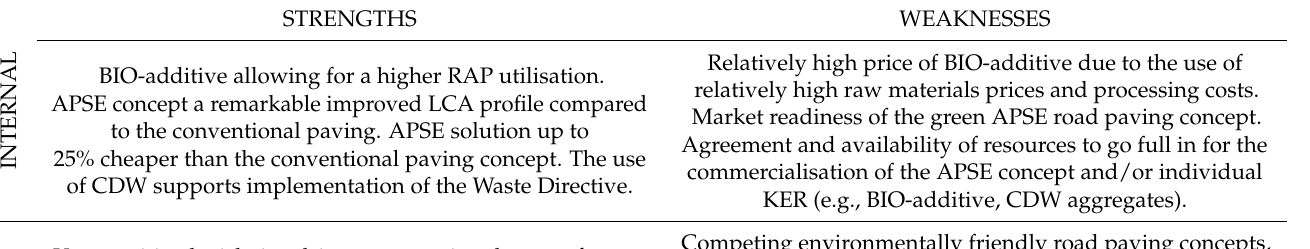
Table 3. SWOT analysis for sustainable road structure produced by using APSE